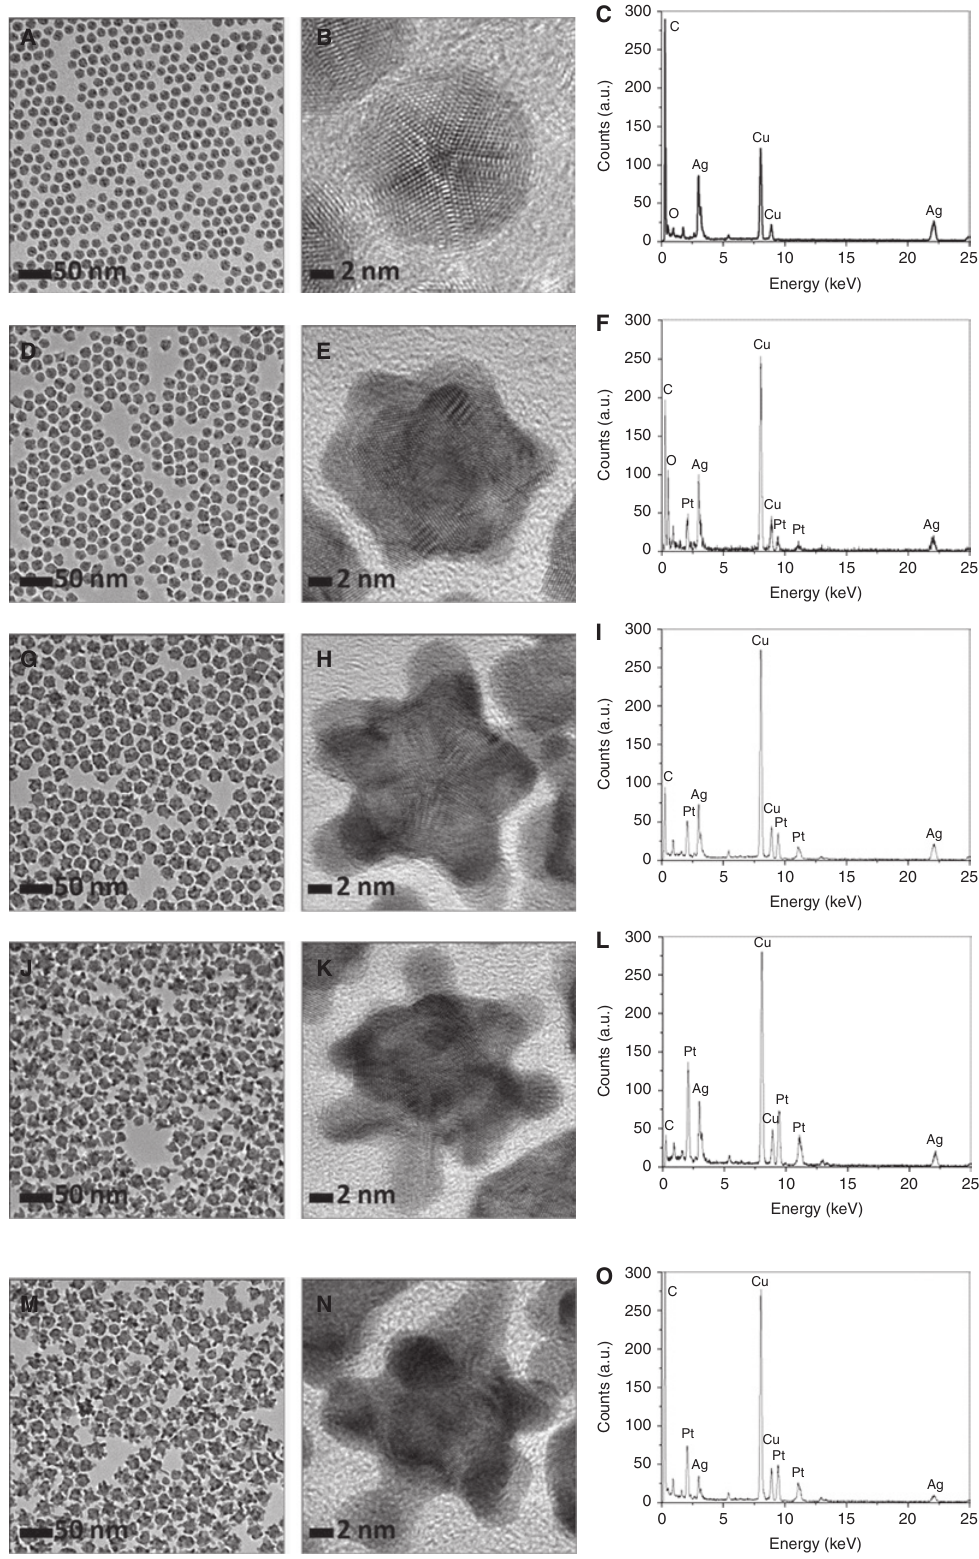
Figure 1: Representative TEM images (A, B, G, J, M), HRTEM images (B, E, H, K, N) and corresponding EDX spectra (C, F, I, L, O) of the stellated Ag-Pt nanoparticles made after the reaction for 30 min (A, B, C), 60 min (D, E, F), 90 min (G, H, I), 120 min (J, K, L) and 180 min (M, N, O), respectively. Reproduced from [33] with permission from Nature Publishing